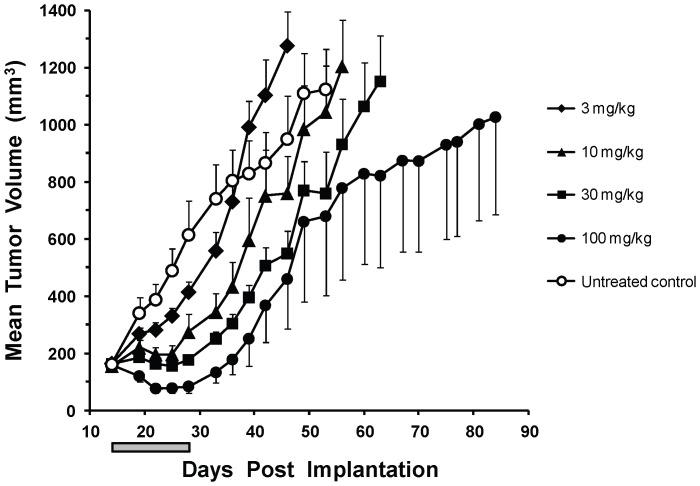
Inhibition of BRAFV600E tumor xenograft growth by dabrafenib.Growth of Colo 205 tumor xenografts was measured in mice during and for a period following oral q.d. × 14 treatment with 0, 3, 10, 30, and 100 mg/kg dabrafenib. Mean tumor volumes are plotted with their standard error mean and 4 partial regressions out of 8 mice were observed at the 100 mg/kg dose after the 14-day treatment period. The 14-day period of dosing is indicated by the shaded gray bar.